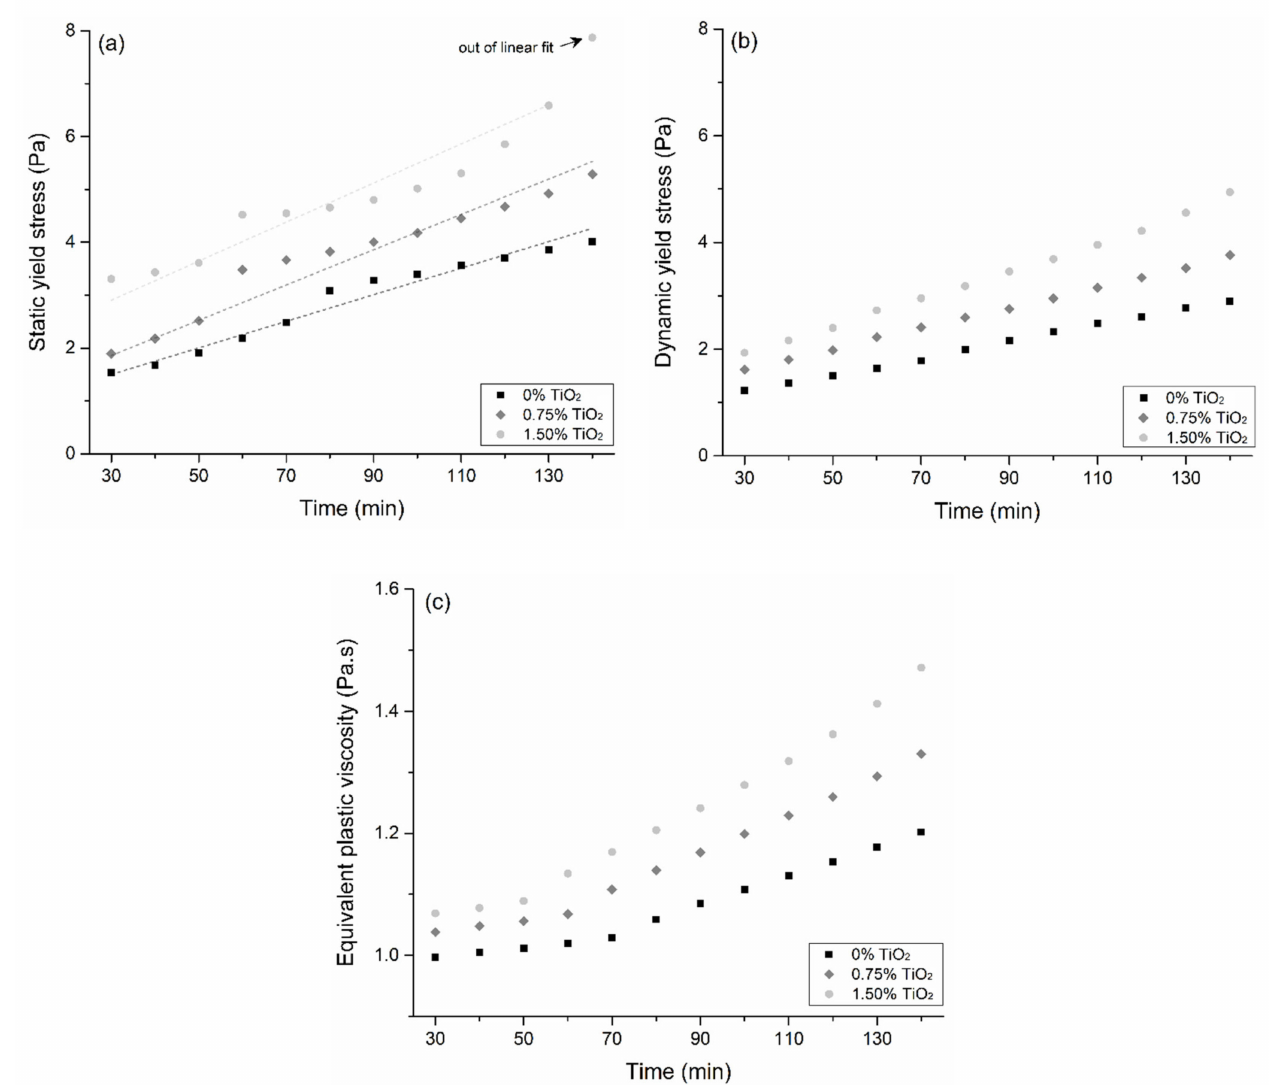
Figure 5. Rheological properties of the pastes over time. ( a ) static yield stress; ( b ) dynamic yield stress; ( c ) equivalent plastic